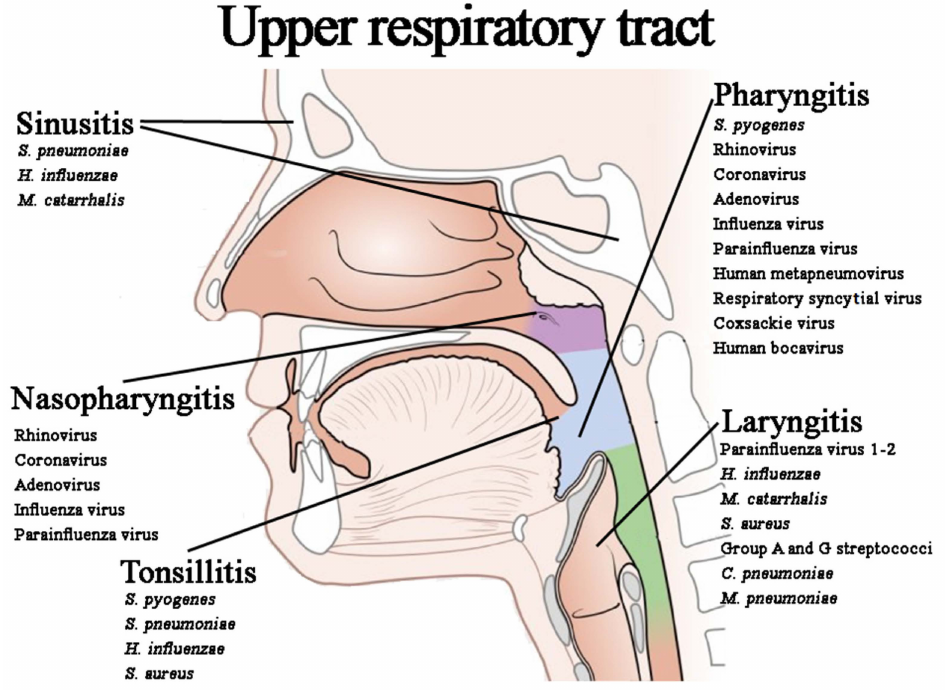
Figure 1. Classification of the URIs with the associated most relevant causative